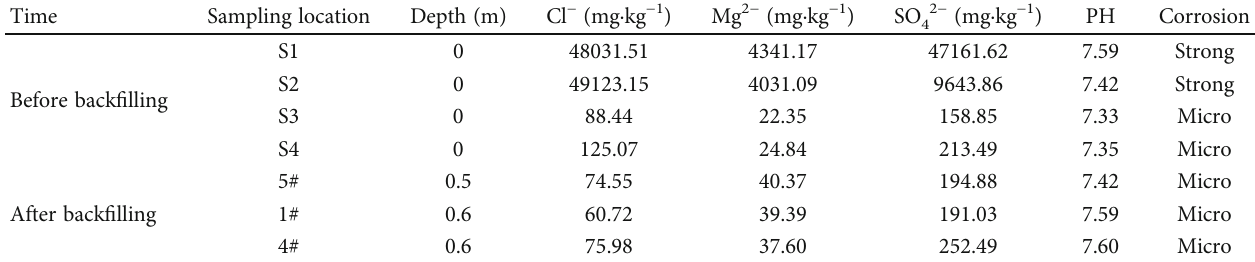
Table 1: Soil corrosion before and after back fi lling.